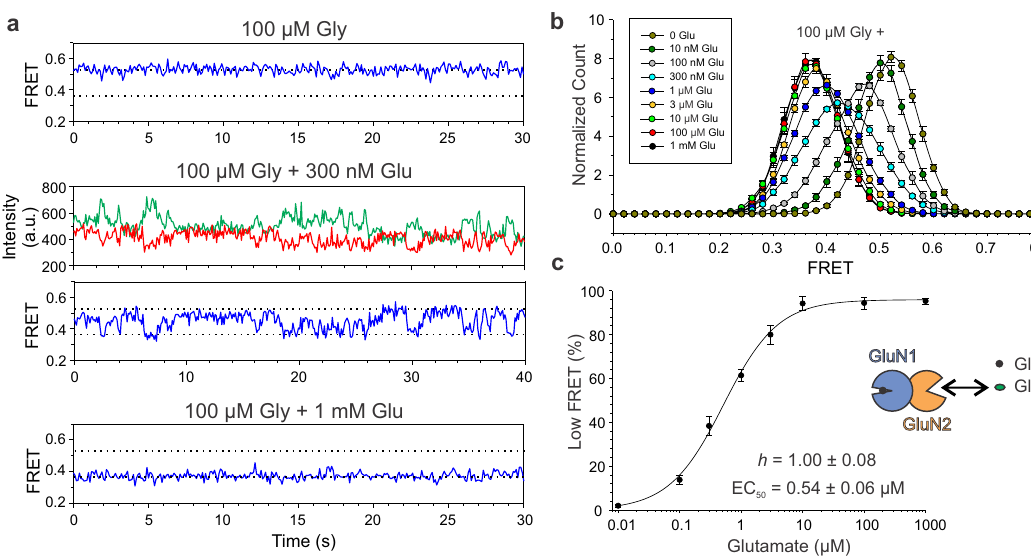
Fig. 3 Glutamate dose – response curve in the presence of glycine. a Representative smFRET traces in the presence of 100 µ M glycine (top), 100 µ M glycine plus intermediate 300 nM glutamate (middle), and 100 µ M glycine plus saturating 1 mM glutamate (bottom). b FRET histograms recorded with increasing glutamate concentration in the presence of 100 µ M glycine. Each histogram n = 5 movies, SEM error bars. c Dose – response curve for glutamate in the presence of 100 µ M glycine ( n = 5 movies, SEM error bars).